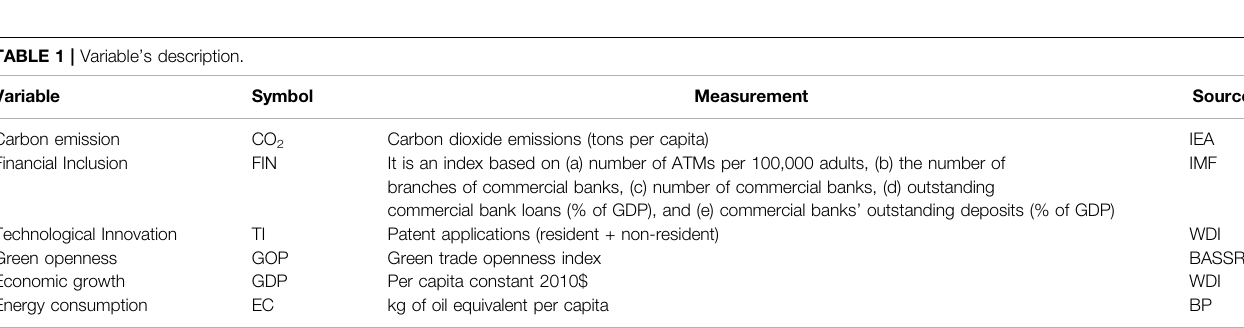
TABLE 1 | Variable ’ s